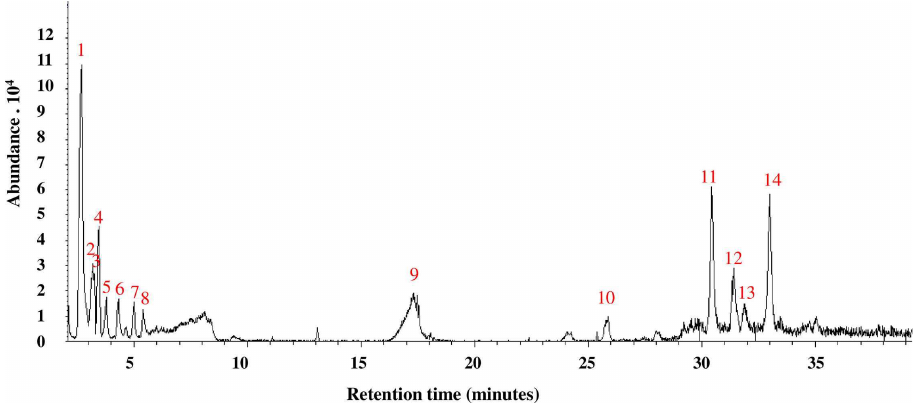
Figure 2. GC-MS analysis of P. ostreatus aqueous extract.